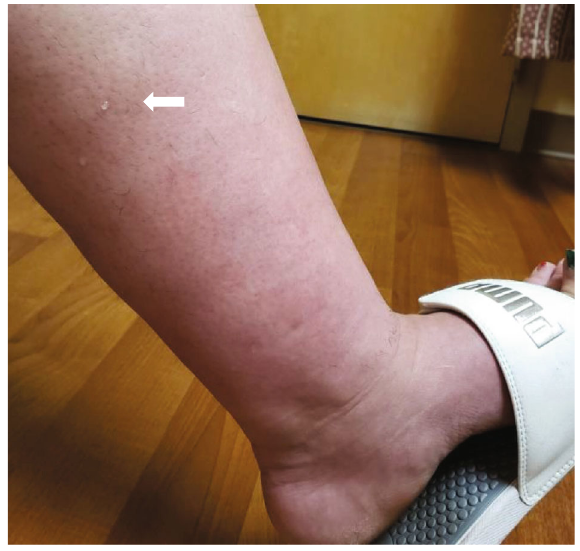
Figure 2: A photograph of the left calf taken by Kaori Morimoto during the prenatal visit. The patient was 31-week and 4-day gestation. Signi fi cant bilateral leg edema was noted along with the constant seeping indicated with the white